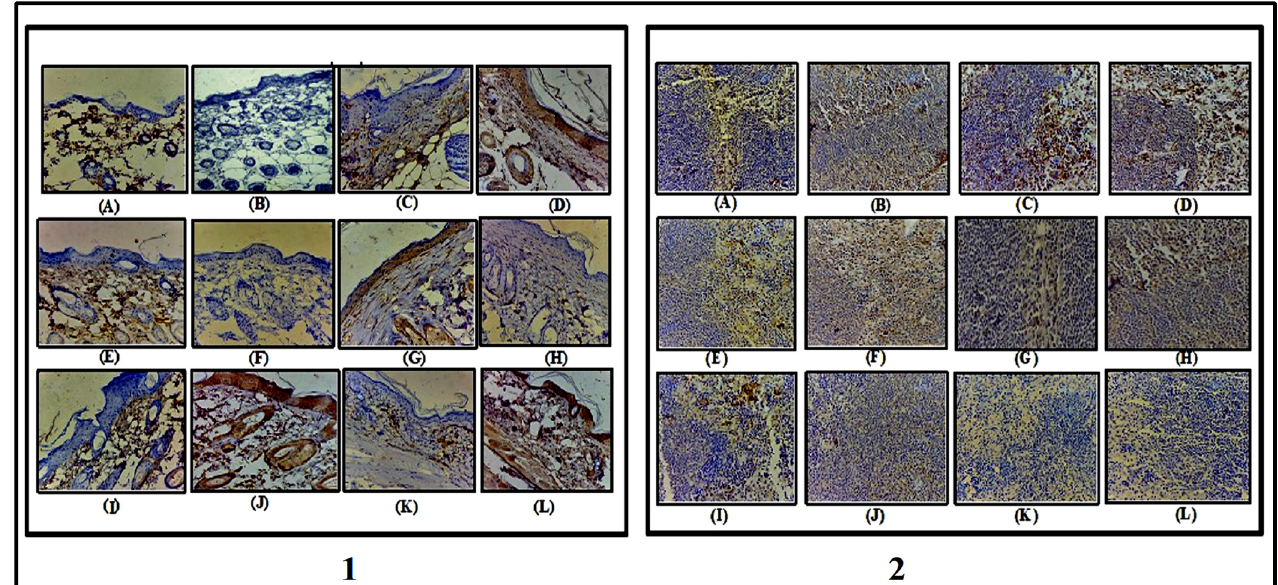
Figure 10. Immunohistochemistry of skin ( 1 ): (A,B) Control group of TNF- α and IL-6, (C,D) Negative control, (E,F) FTQ-NEG, (G,H) FA, (I,J) FD gel, (K,L) Positive control. ( 2 ) Immunohistochemistry of spleen: (A,B) Control group of TNF- α and IL-6, (C,D) Negative control group, (E,F) FTQ-NEG group, (G,H) FA, (I,J) FD gel, (K,L) Positive control (IHC, TNF- α , IL-6 400×).